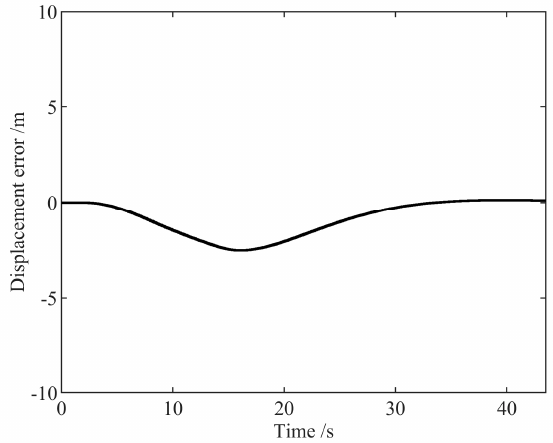
Figure 27. Displacement error between P and the reference path in the third group of simulations.